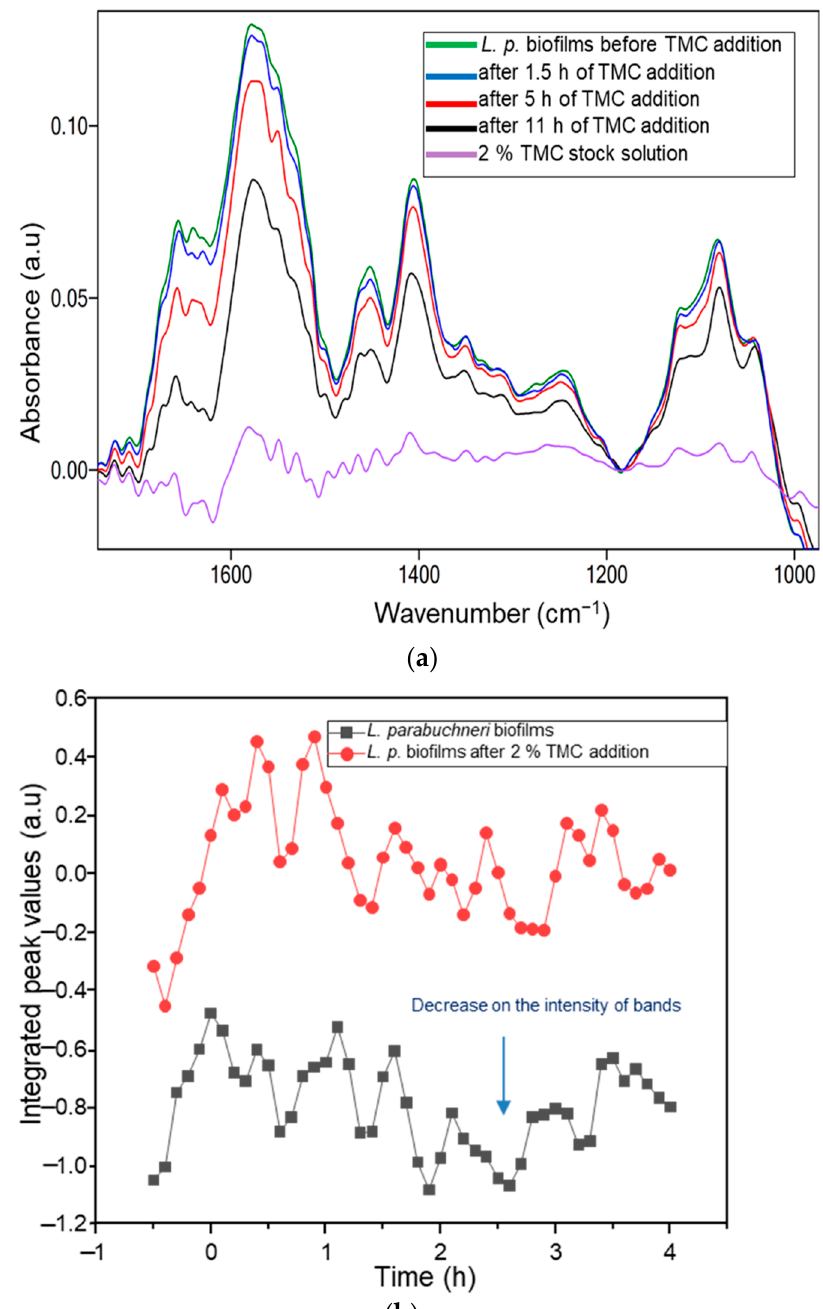
Figure 4. ( a ) IR-ATR spectrum of L. parabuchneri biofilm disruption after the insertion of TMC; ( b ) integrated peak values (IPVs) as a function of time for the spectral window 1700–900 cm − 1 . Changes in integrated peak areas of spectral signature characteristics of biofilms, that is, amide I and II (1700–1464 cm − 1 ), amide III (1350–1200 cm − 1 ), nucleic acids (1280–1180 cm − 1